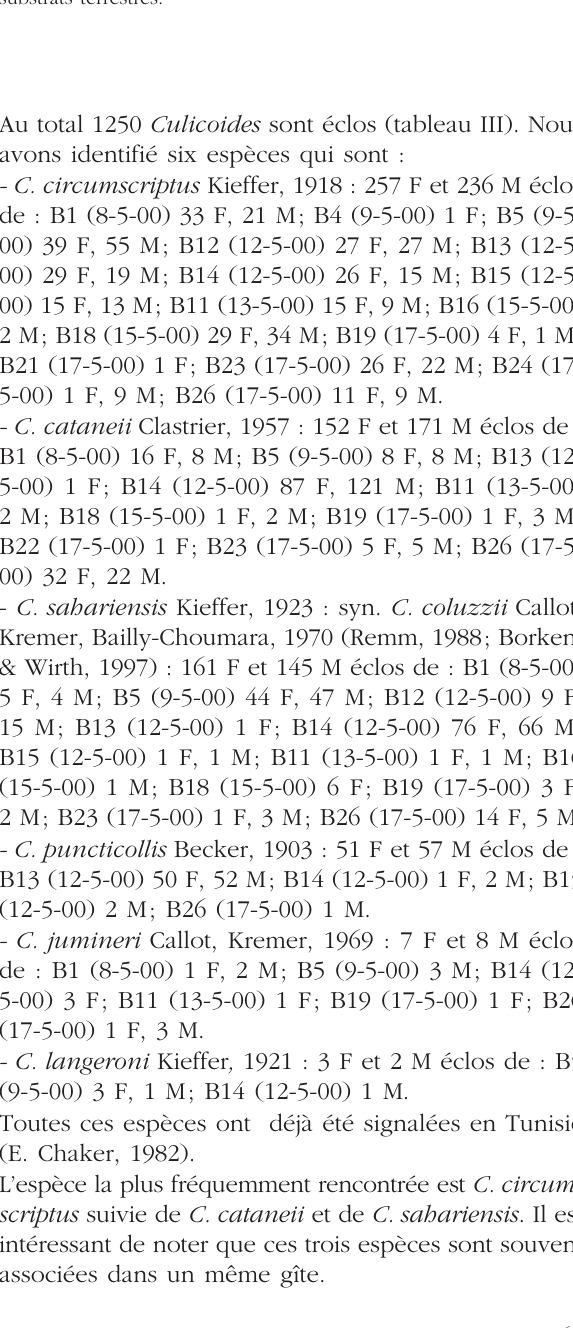
Tableau III – Fréquence des espèces écloses des prélèvements de substrats